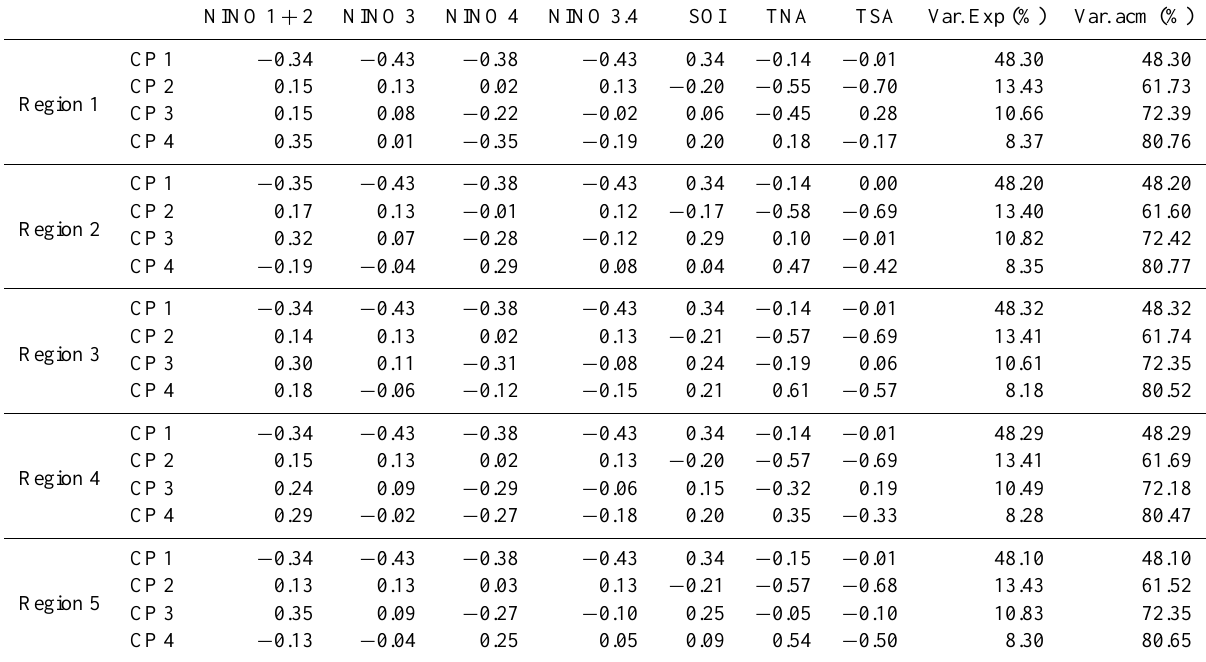
Table 3. Variables that influence the main component in